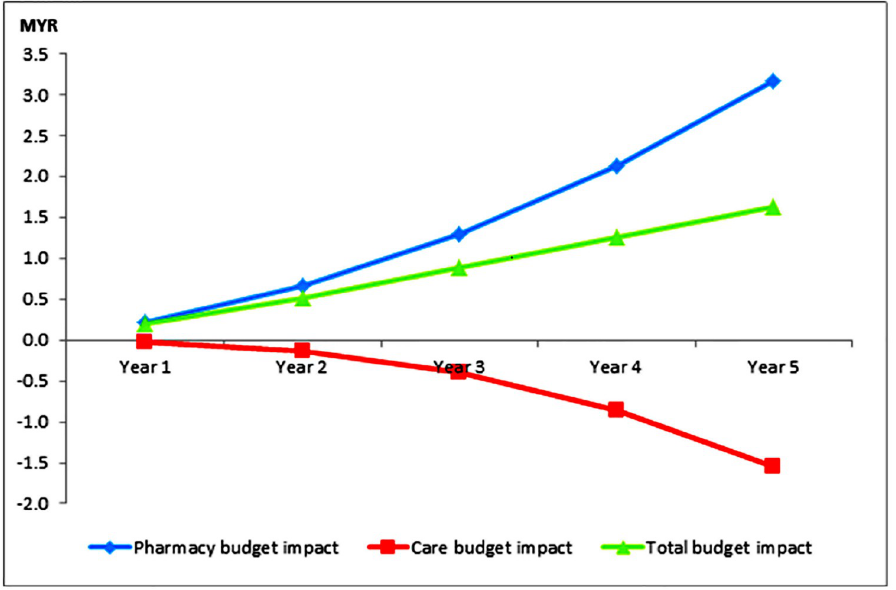
Fig 2. Incremental per-member per-month (MYR) cost impact after increasing uptake of renin-angiotensin system inhibitor